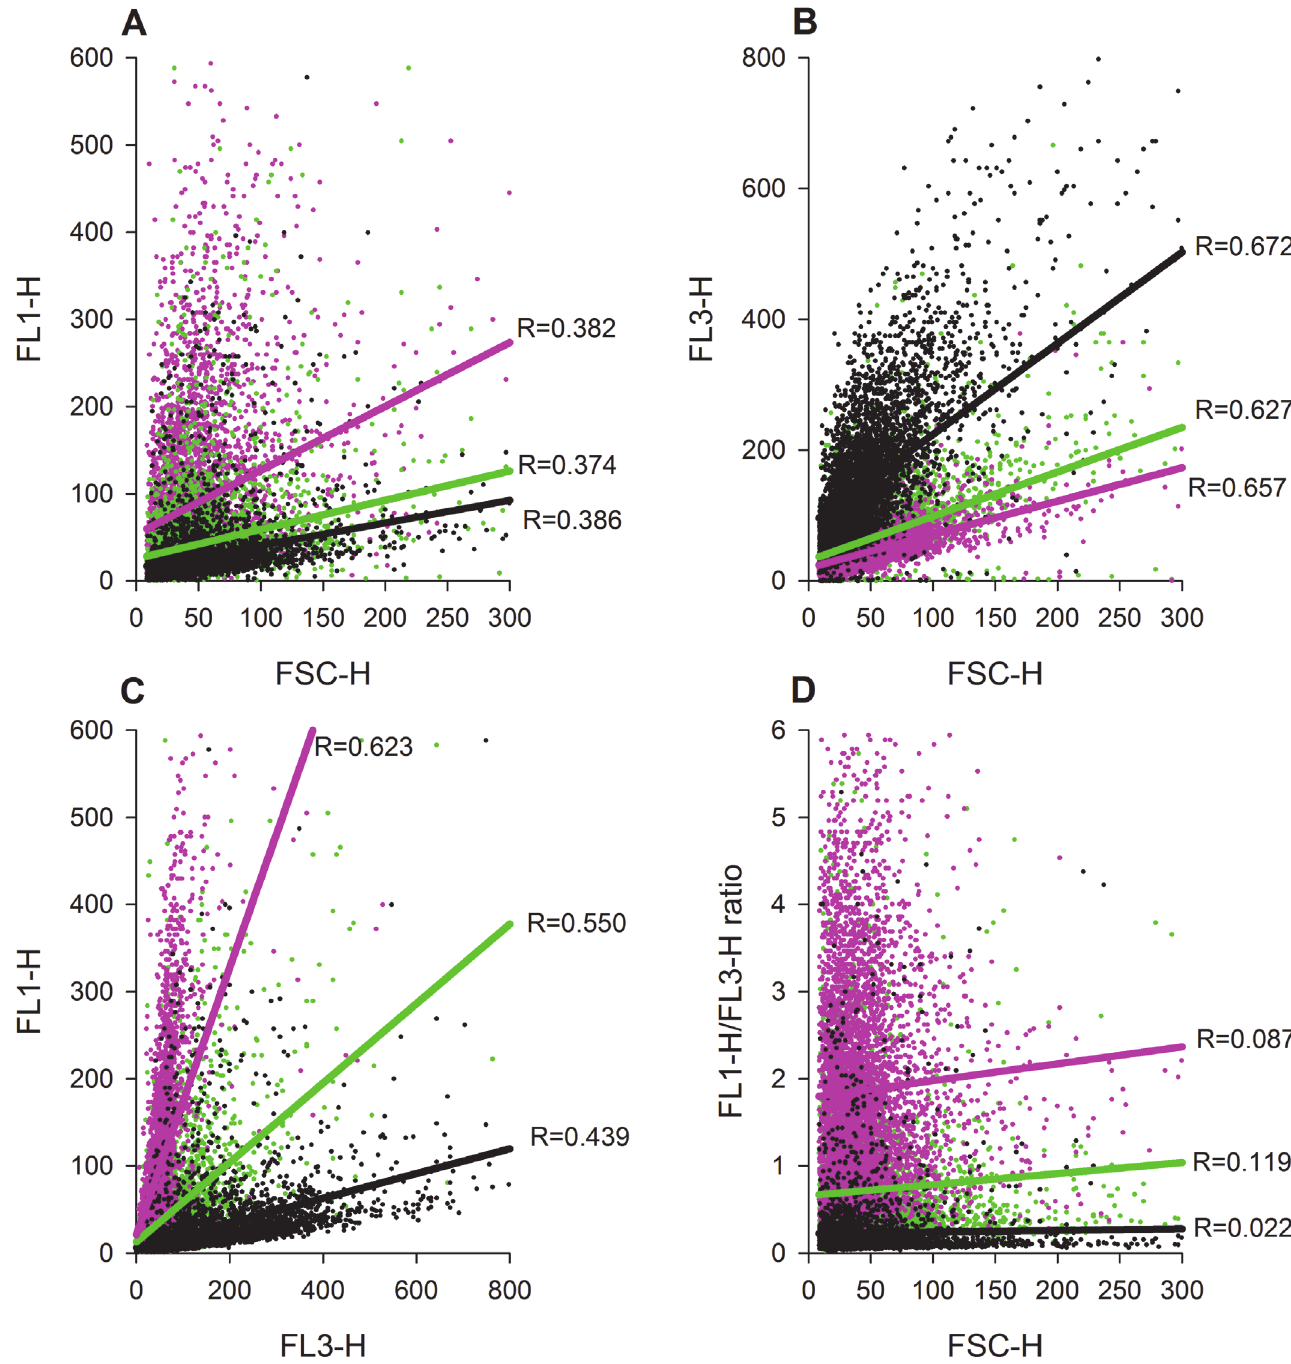
Fig 4. Correlations between Fluo-4 and Fura Red fluorescence with event size at three different Ca 2+ concentrations (0, 413 or 1012 nM free Ca 2+ ): (A) Correlation between Fluo-4 fluorescence (FL1) and event size (FSC). (B) Correlation between Fura Red fluorescence (FL3) and event size (FSC). (C) Correlation between Fluo-4 fluorescence (FL1) and Fura Red fluorescence (FL3). (D) Correlation between Fluo-4/Fura Red (FL1/FL3) ratio and event size (FSC). Black = Ca 2+ free buffer; green = 413 nM free Ca 2+ ; magenta = 1012 nM free Ca 2+ . In all subfigures the regression coefficient R are given as insets for each Ca 2+ concentration